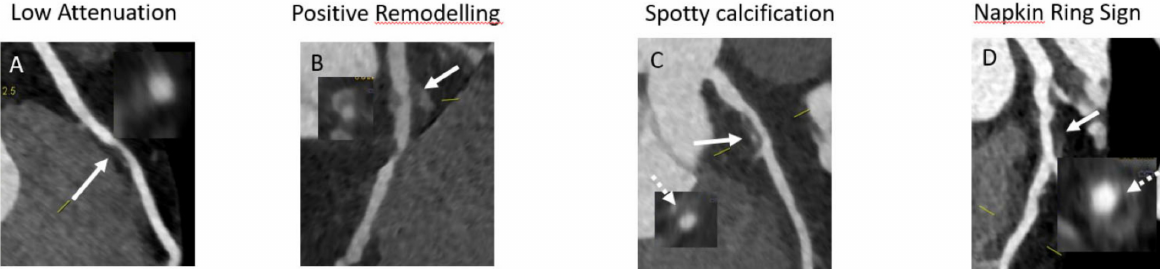
Figure 8. Examples of high-risk plaques. ( A ) Low-attenuation plaque (white arrow). ( B ) Positive remodeling—note the development of the plaque outside the coronary lumen (white arrow). ( C ) Spotty calcification—note the presence of calcium in an otherwise low-attenuation plaque (white arrow). ( D ) Napkin-ring sign—a heterogenous low-attenuation plaque (white arrow) that exhibits a cap with lower HU densities (interrupted white arrow) in comparison to the rest of the